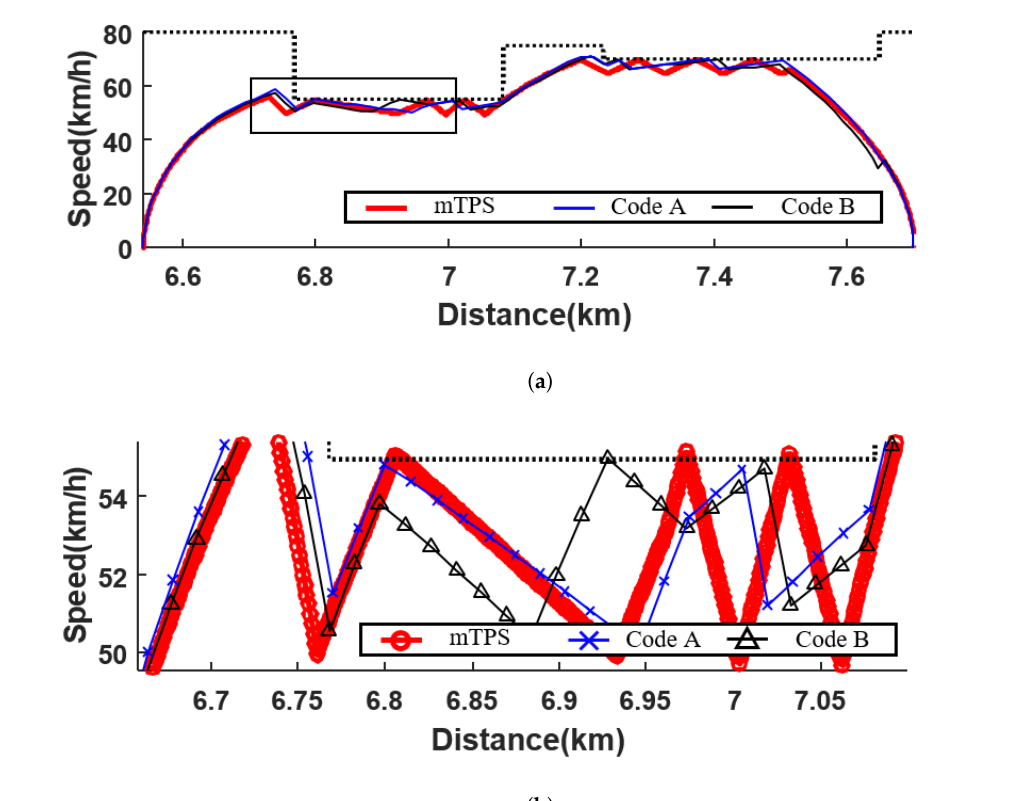
Figure 13. Verification of mTPS with legacy codes. ( a ) Comparative study for mTPS result and code A, B. ( b ) Magnified figure for Figure